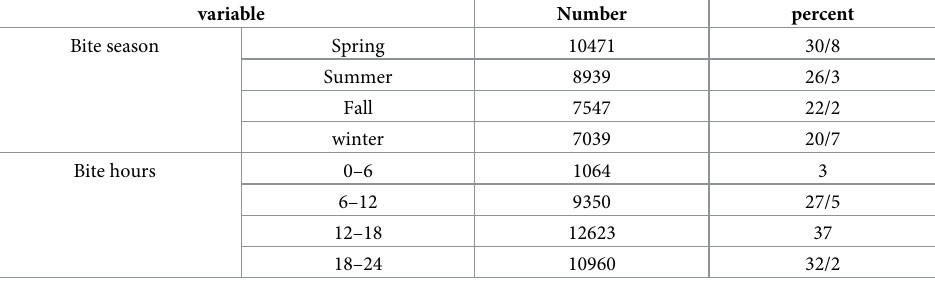
Table 2. Temporal aspects of the animal